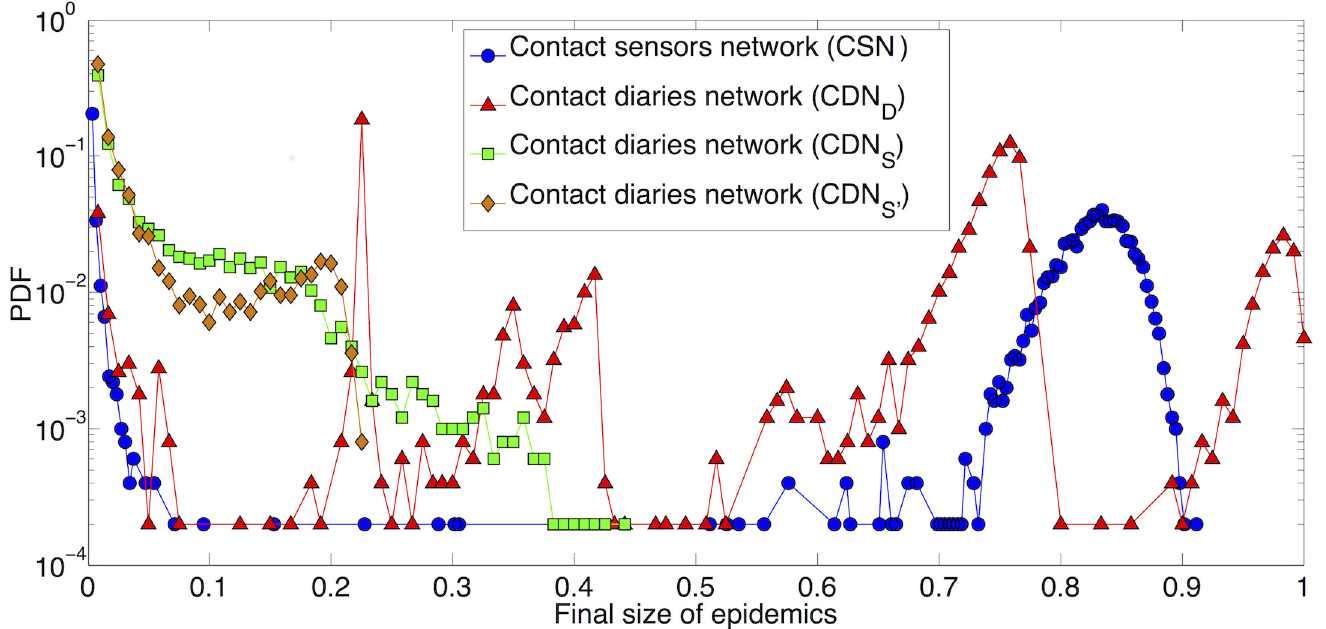
Fig 1. Distribution of final size of epidemics. 1000 SIR simulations performed on the original contact sensors network (CSN) and the original contact diaries network with durations respectively reported by students (CDN D ) and registered by sensors (CDN S and CDN S ’ ). Each process starts with one random infected seed. β / μ =